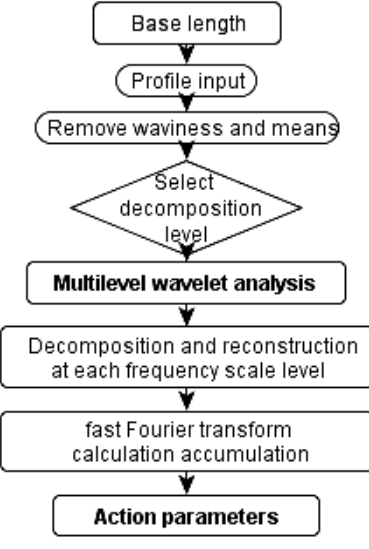
Fig. 8. Scheme of algorithm determines the action parameters of the